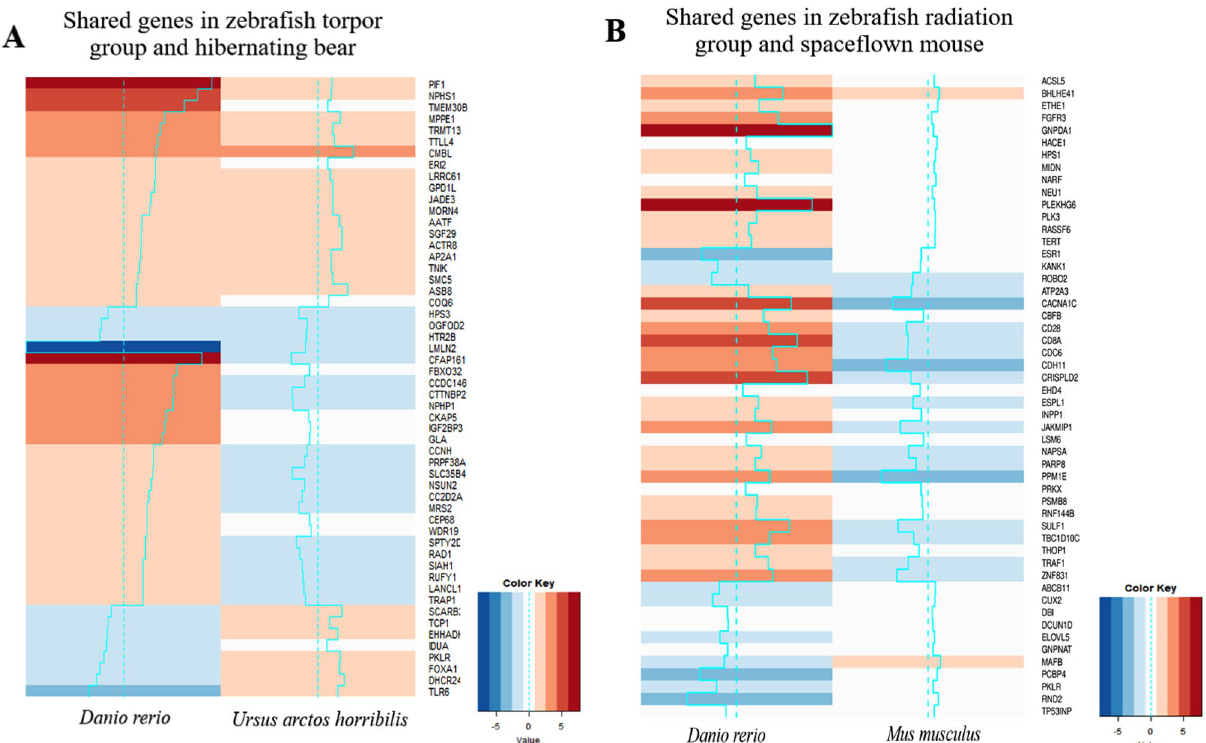
Figure 5. ( A ) Comparison of zebrafish torpor and hibernating bear genes. A heat map of the 54 shared genes between the zebrafish torpor group and the hibernating bear showing their direction of expression relative to the active controls ( B ) Heat map of the 52 shared genes between the zebrafish radiation group and the space flown mouse liver showing their direction of expression (red = upregulated, blue =